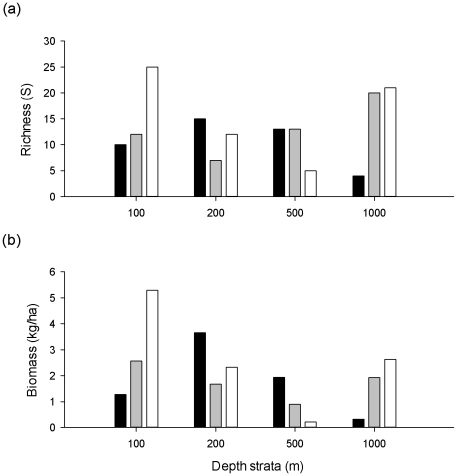
Bar graphs of demersal fish richness and biomass collected from trawl shots at 4 depth strata (100 m, 200 m, 500 m, 1000 m) around the head of Bonney Canyon.Locations relative to the main canyon axis are represented by different shades of fill (black = west, grey = centre, white = west).